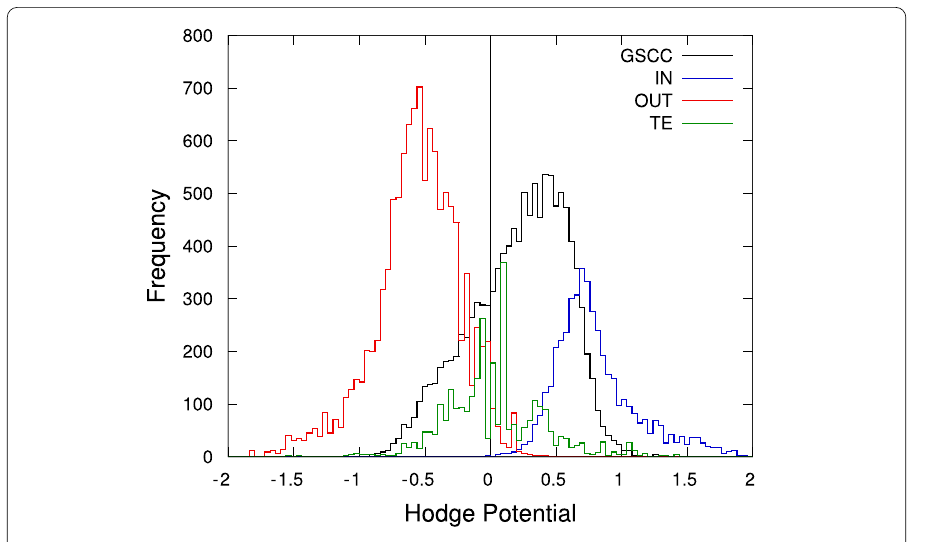
Figure 8 Distribution of the Hodge potentials of individual accounts. Distributions as histograms of φ i in each component of the bowtie or walnut structure Fig. 7. The horizontal axis represents the value of φ i of an individual node or account, while the vertical axis represents the frequency in the histogram. The black line corresponds to GSCC or the core. The blue and red lines, respectively, correspond to the IN and OUT components or upstream and downstream with respect to the core. The green line corresponds to TE (tendrils) or the rest of the